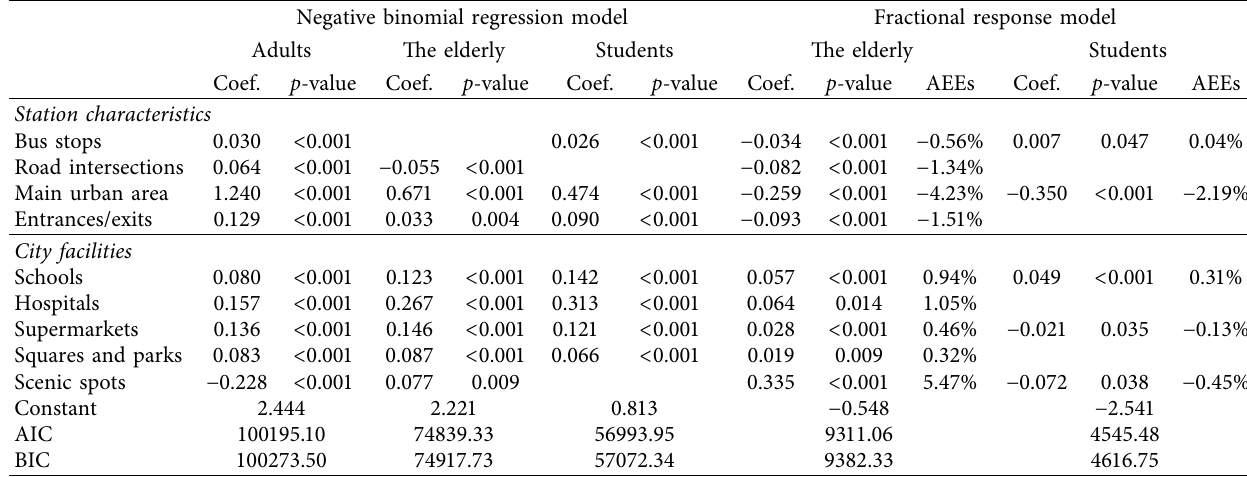
AEEs refer to the average elasticity